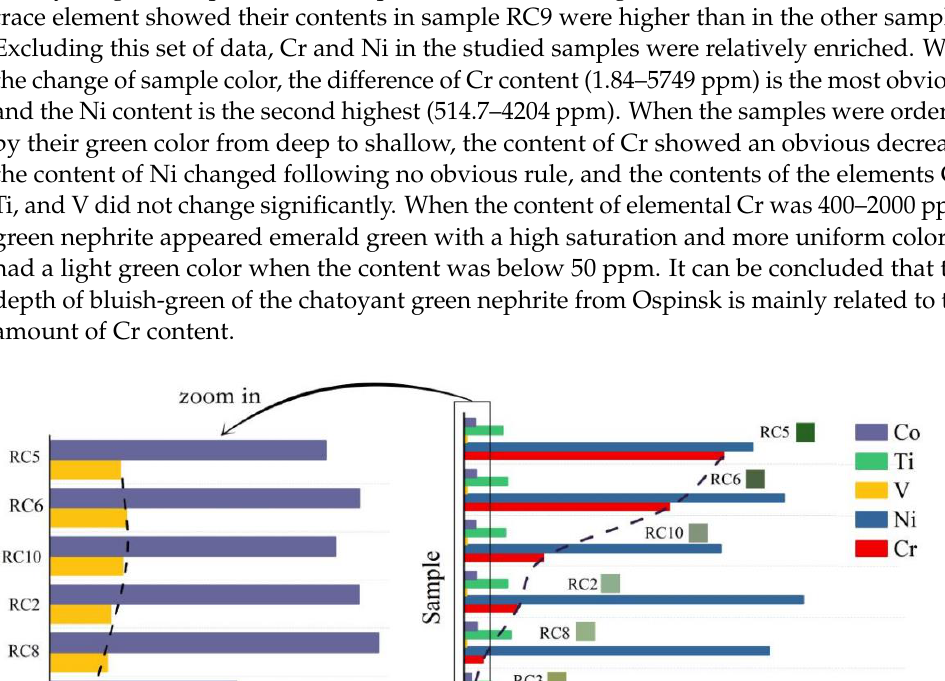
Figure 13. ( a ) Characteristics of Zr/HF and Sr/Ba ratios of green nephrite from different areas. ( b ) Characteristics of Nb/Ta and Sr/Ba ratios of green nephrite from different areas. 5.2. Formation Temperature of Graphite Carbonaceous materials are widely found in metamorphic rocks, especially in those with a sedimentary protolith [87]. Unstable carbonaceous materials gradually change to stable graphite with burial and metamorphism. The degree of graphitization is associated with the peak metamorphic temperature, and is not affected by retrogression [88].